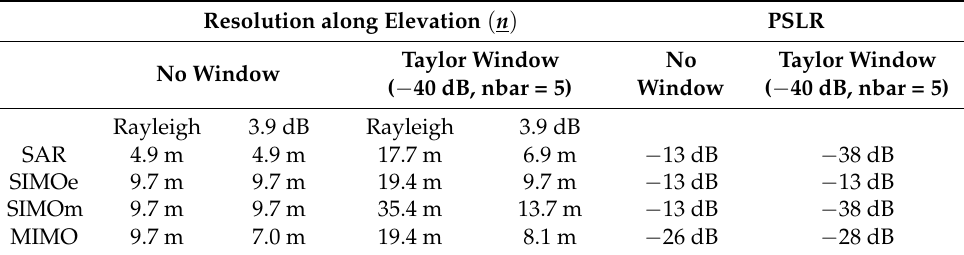
Table 3. Measured tomographic resolutions and sidelobe levels with and without windowing.